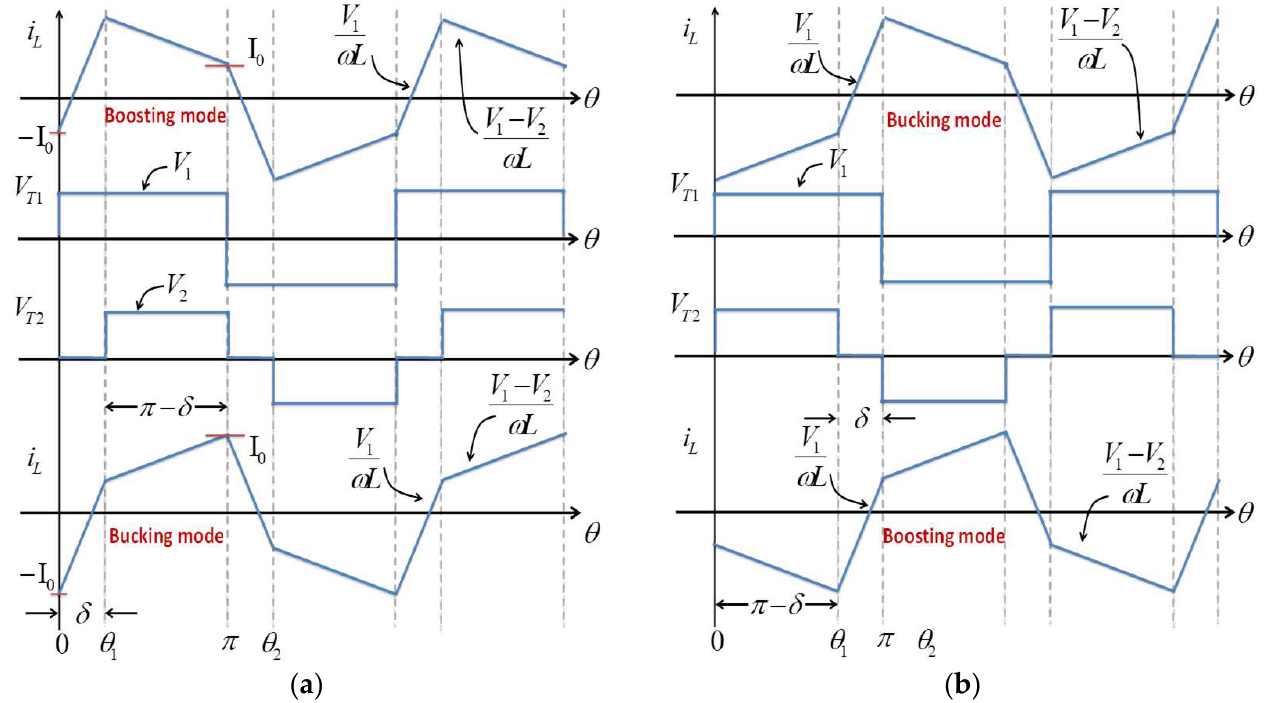
Figure 5. Boost modulation waveforms: ( a ) direct power transfer, ( b ) reverse power transfer.